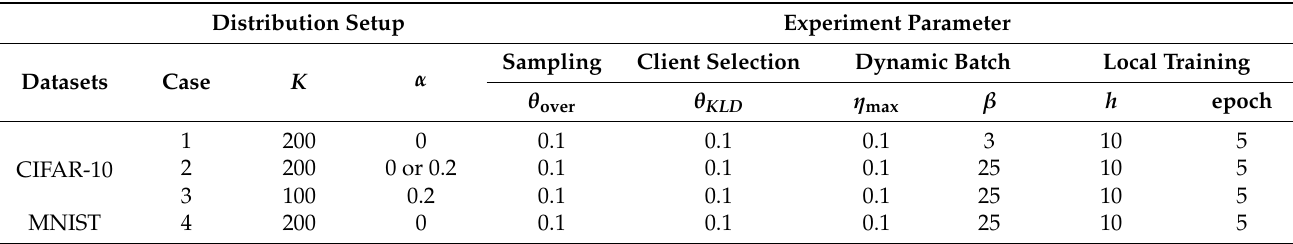
Table 2. Distribution setup and experiment